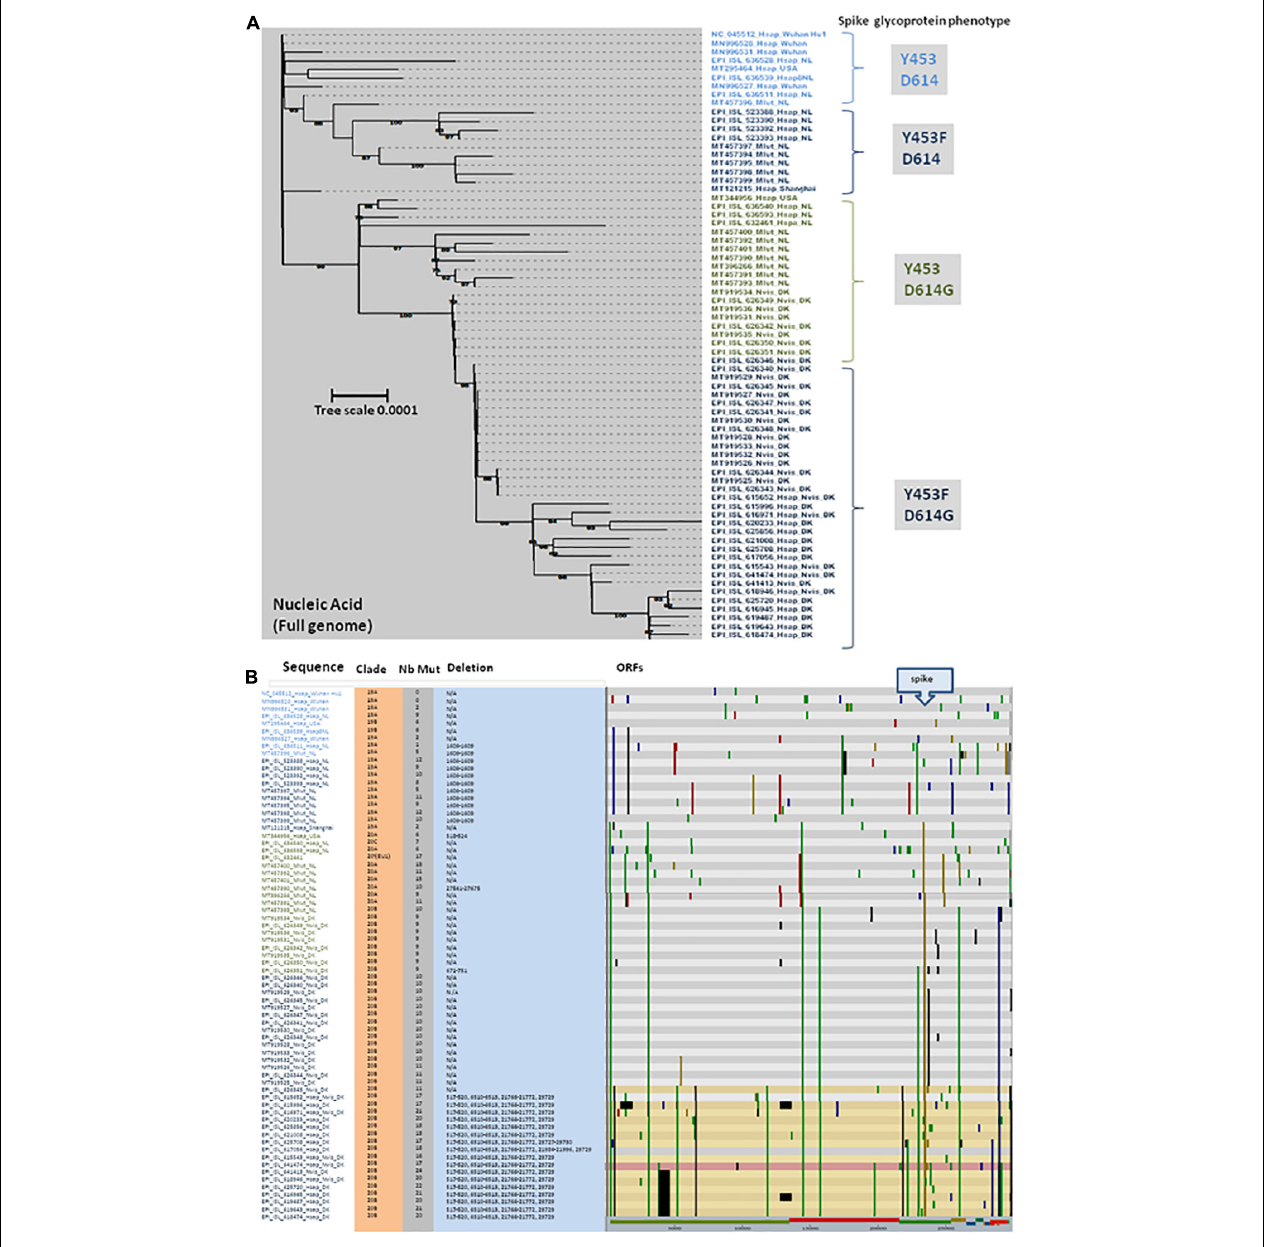
FIGURE 6 | (A) Maximum likelihood phylogenetic tree of different genomic SARS-CoV-2 sequences. Sample names are built with the GISAID or GenBank accession number followed by a four-letter code (Mlut, Nvis, and Hsap) identifying the species followed by a code indicating the geographical origin of the sample (Wuhan: Wuhan, China; NL: Netherlands; DK: Denmark; and USA: United States). This analysis compares the full genome sequence from minks (Mlut: M. lutreola or Nvis: N. vison ) and human (Hsap). The main spike phenotype (amino acid substitution) of each group of SARS-CoV-2 is indicated on right side of the figure. Four different groups where identified: Y453/D614, Y453F/D614, Y453/D614G, and Y453F/D614G. (B) Location of genomic mutations and deletions on the complete nucleotide sequence from different isolates of SARS-CoV-2. Color code: red, mutation to A; blue, mutation to C; green, mutation to T; yellow, mutation to G; light gray, deletion; and dark gray, not covered. Nb Mut, number of mutations; ORFs, open reading